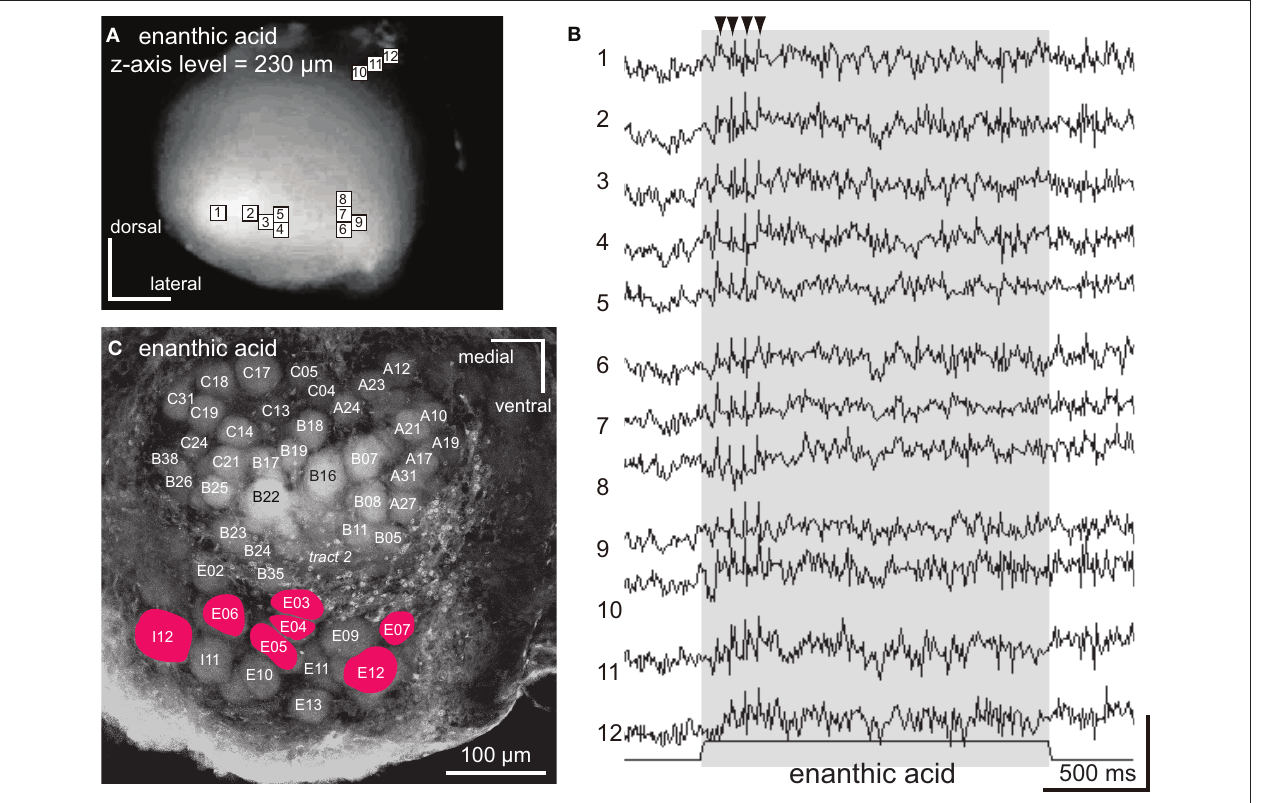
are shown as the changes of the ratio of florescent intensities [vertical scale bar; ( F 0 – F t )/ F 0 × 7 × 10 − 4 ]. (C) A fluorescent image of the recorded AL stained by voltage-sensitive dye. The glomeruli where enanthic acid-induced synchronized potentials evoked were labeled in red. By superimposing the VSD image (A) on the confocal image (C) obtained from a same specimen, glomeruli (colored red) corresponding to the nine pixels (numbered 1–9) were identified and the remaining three pixels (numbered 10–12) were located in the dorsal soma clusters of secondary olfactory